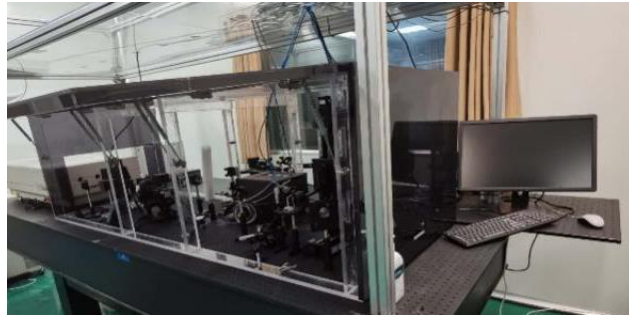
Figure 2. Damaged optics preparation platform.